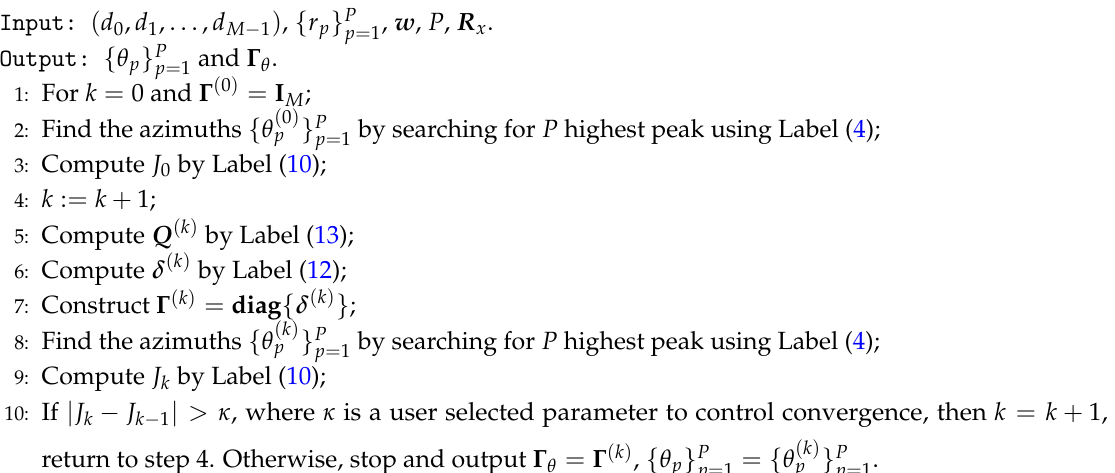
Algorithm 1 Algorithm for the joint estimations of Γ θ and θ